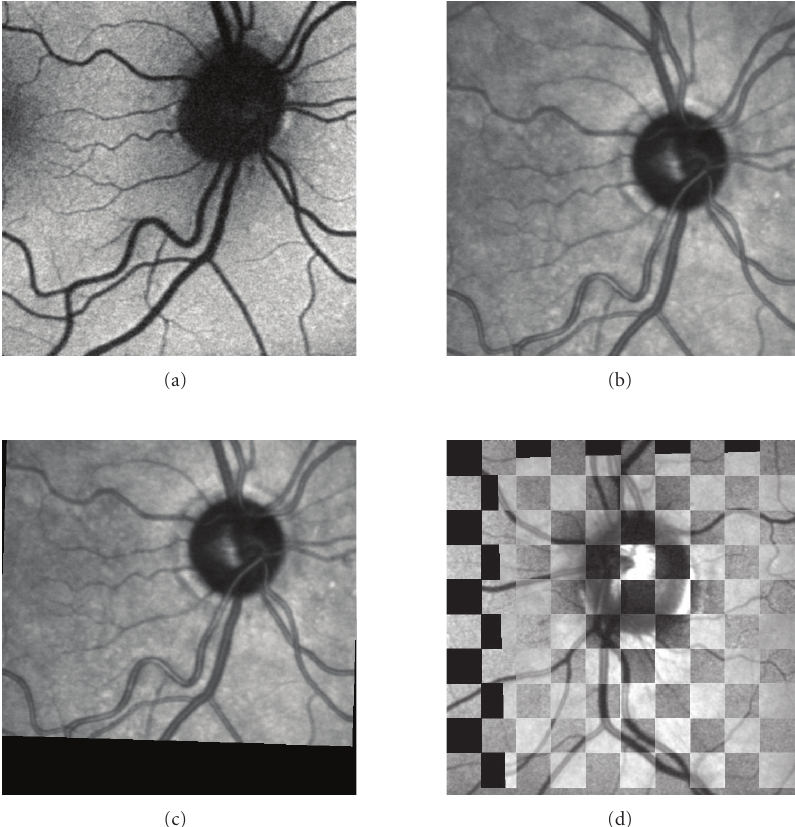
Figure 7: AF-IR registration results: (a) AF image, (b) IR image, (c) registered IR image, (d) mosaic image for evaluation.